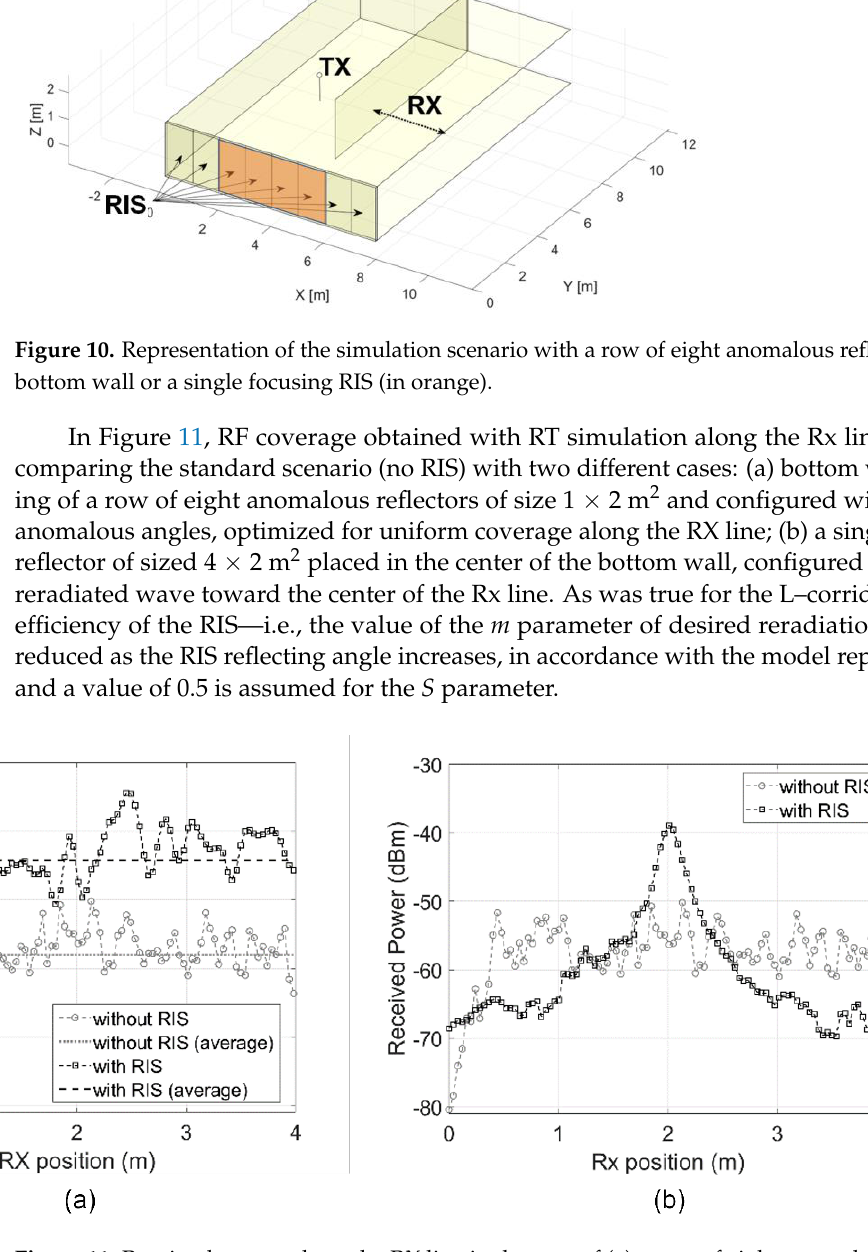
Figure 11. Received power along the RX line in the case of ( a ): a row of eight anomalous reflectors; ( b ) a single focusing reflector.